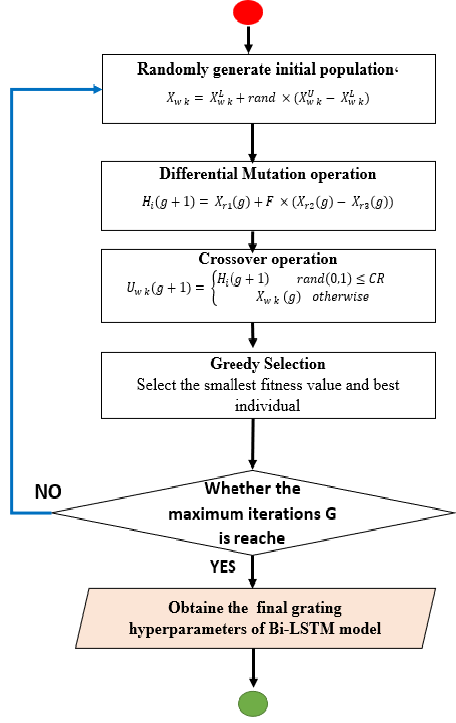
Figure 9. Flowchart of DE algorithm.